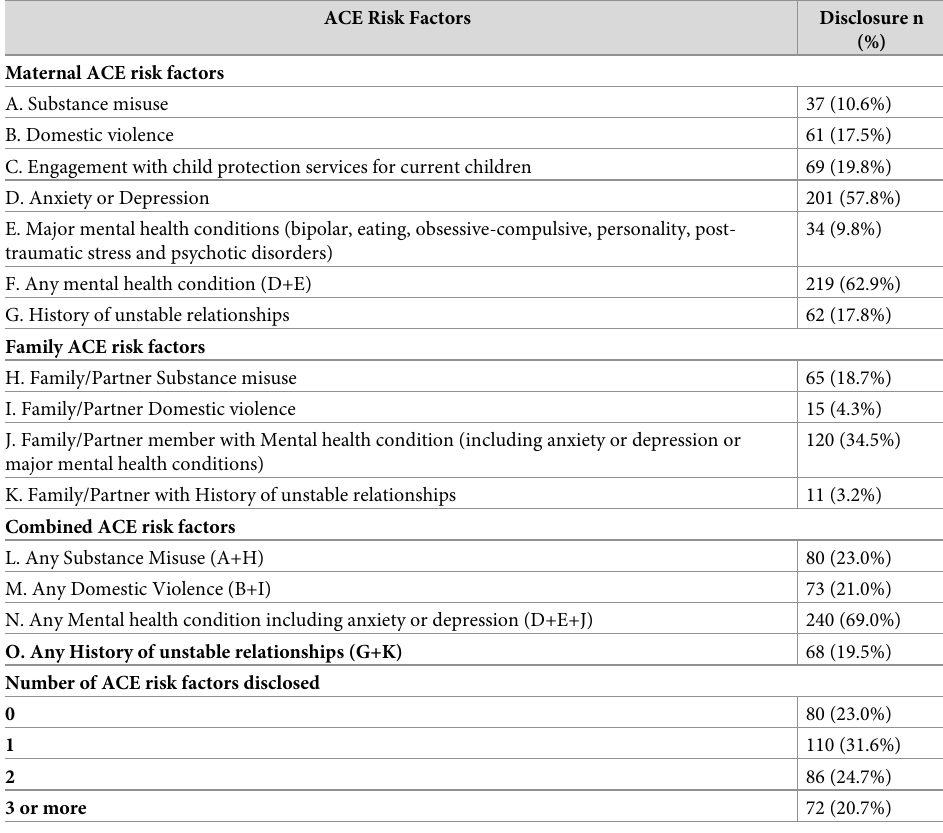
Table 2. Prevalence rates of each ACE risk factor disclosed: Nurse audited participants (n =